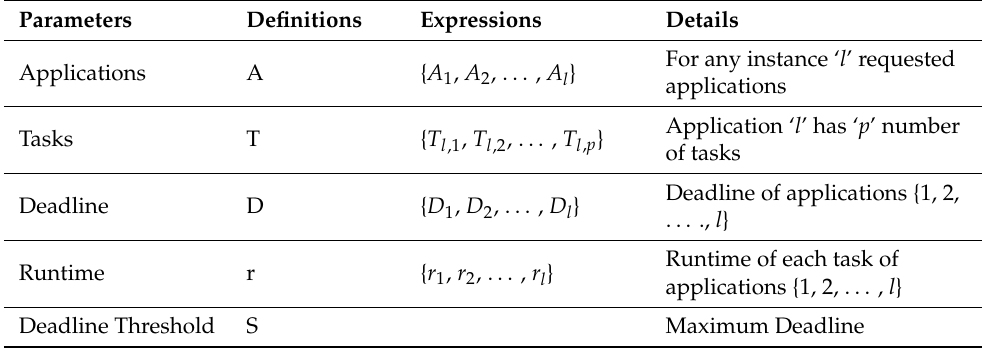
Table 2. Definitions of batch of